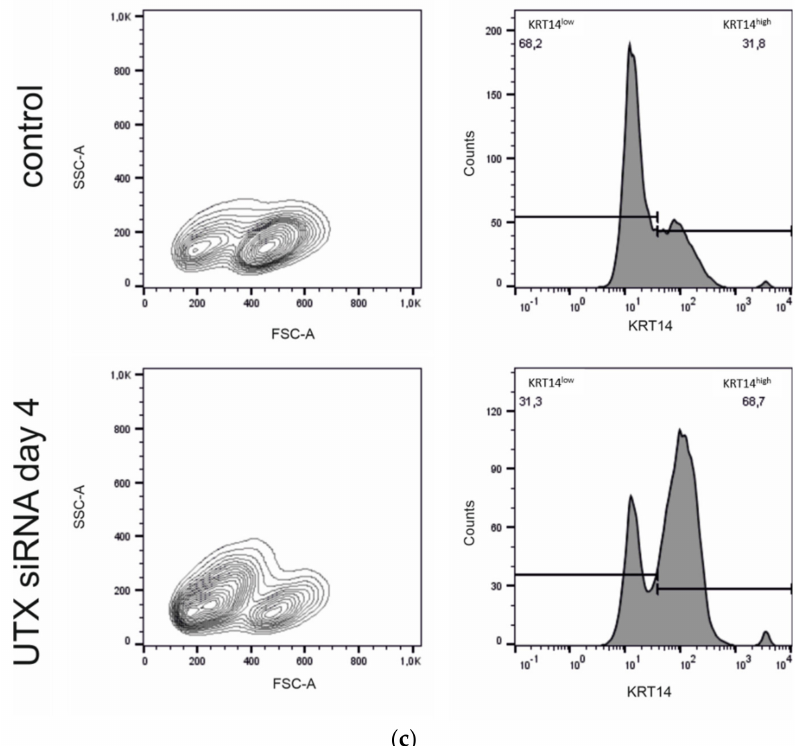
Figure4. EnrichmentofKRT14 high cellsafterUTXknockdowninHBLAKcells. ( a )Immunocytochemical detection of KRT5 and KRT14, nuclei with DAPI and F-actin with phalloidin after transfection with UTX-siRNA for 2, 4 or 7 days. ( b ) Quantification of KRT14 high cells via a cell structure-related signal threshold analysis (ImageJ) in the HBLAK population following UTX knockdown. At least three experiments with > 50 cells each were evaluated for each treatment and time point. The percentage of KRT14 high cells was measured via ImageJ analysis, as described in the Methods section. ( c ) KRT14 expression as detected by flow cytometry on day 4 after transfection of control siRNA or UTX-siRNA ( n = 4). Statistics were performed with a two-way ANOVA with a post-hoc Tukey HSD test (## p < 0.01; ### p <